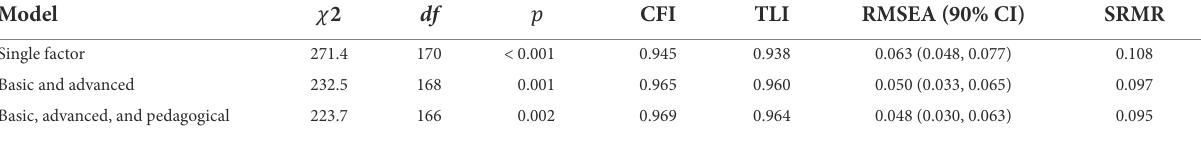
TABLE 3 Fit indices different numbers of factors in a CFA (task and software related statements, 𝑁 = 152). Model